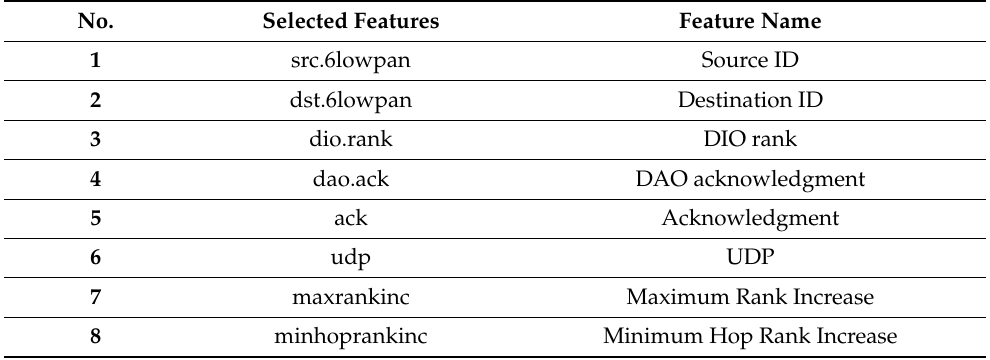
Table 3. The selected features for model